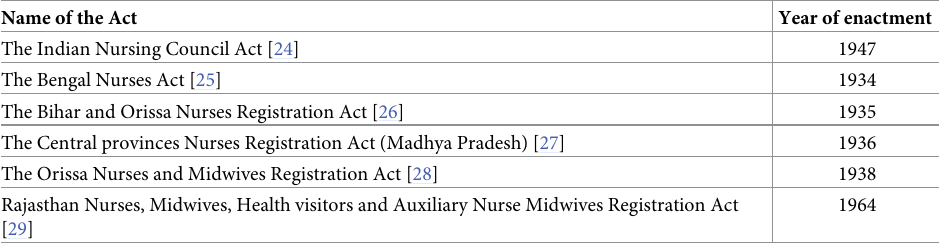
Table 2. Nursing and midwifery Acts reviewed, by year of